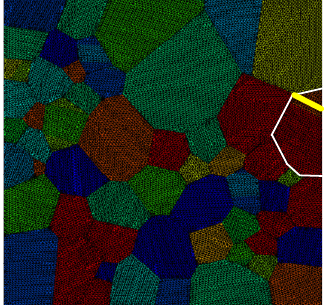
Figure 11. Crack nucleation FIP ave( 𝛂 ) distribution diagram.